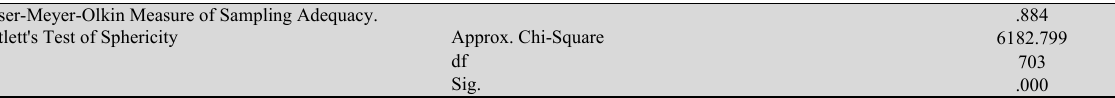
EFA analysis results (KMO and Bartlett's Test) Kaiser-Meyer-Olkin Measure of Sampling